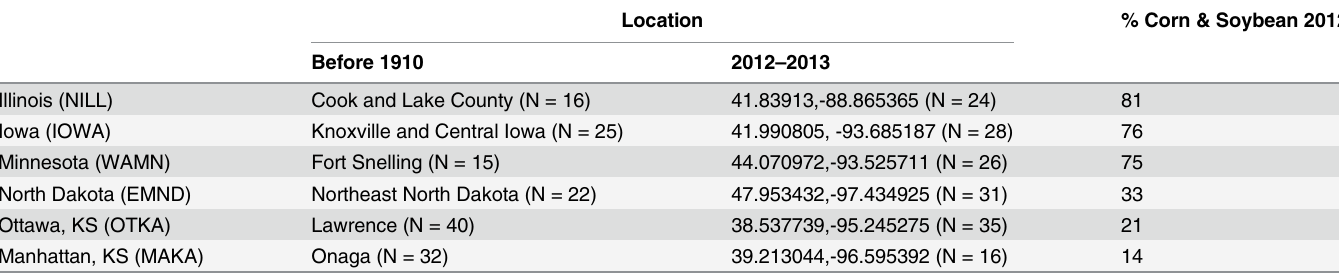
Table 1. Summary of specimen collection sites.